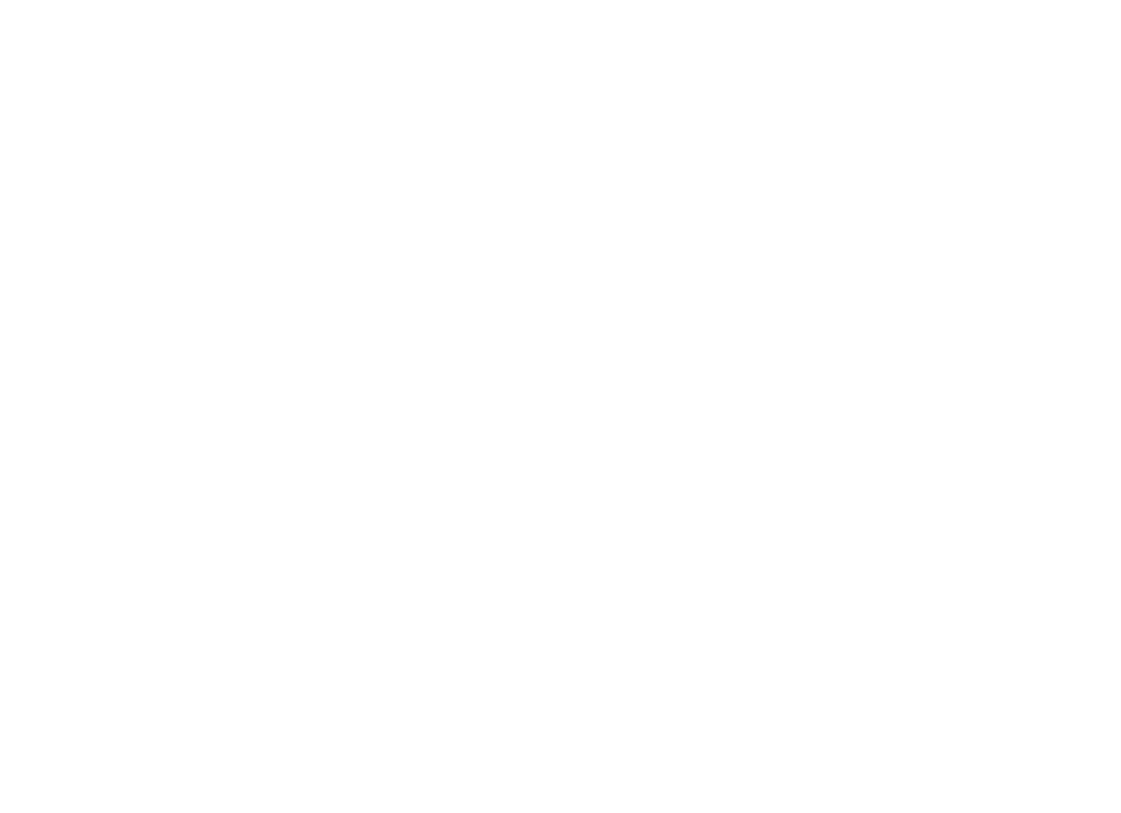
FIGURE 1 | Growth of the putative Fusarium isolates of tomato on potato dextrose agar medium. (1) TOFOL-IHBT; (2) TOFU-2-SOGHI; (3) TOFU-3-B.GHAT; (4) TOFU-IHBT; (5) TOXX- POT-1; (6) TOXX- POT- 2; (7) TOFU-KOTBEJA-1; (8) TOFOL-CBE; (9) TOFS-CPCT-2; (10) TOFS-3-CPCT; (11) TOFU-MM; (12) TOFS-MU; (13) TOFU-4-CPCT; (14) TOFU- 6-CPCT; (15)TOFU-TISSA-4; (16) TOFS-IIVR; (17) TOFU-SN; (18)